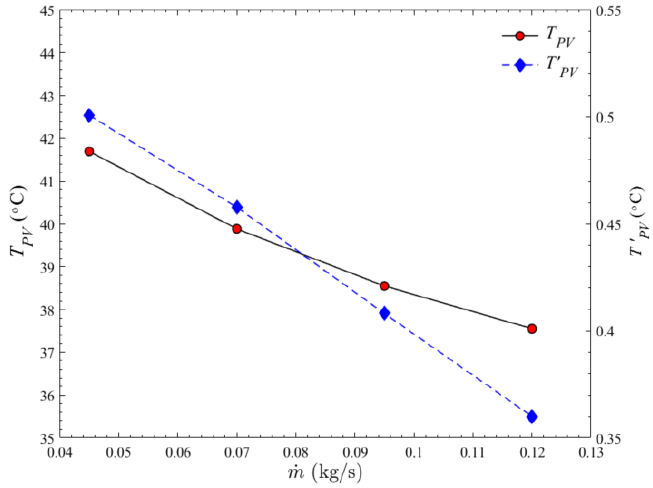
Figure 5. Effect of mass flow rates on the PV temperature and its uniformity at c = 2%, I = 1000 W/m 2 , h sl = 107.1 kJ/kg, N = 8, and H = 30 mm.